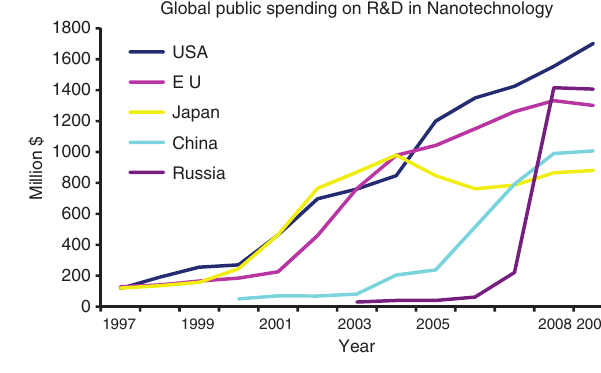
Figure 1 Government expenditure on R&D in nanotechnology.